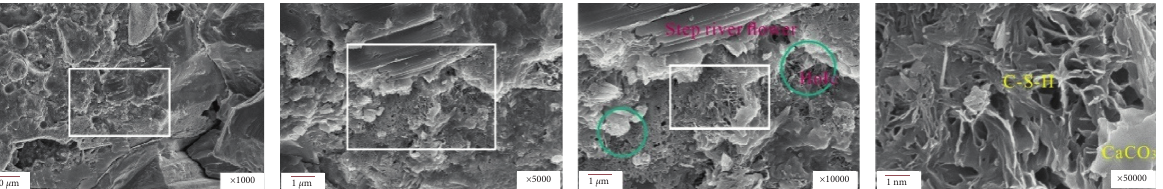
Figure 19: C-0 concrete microstructure before sample freeze-thaw.